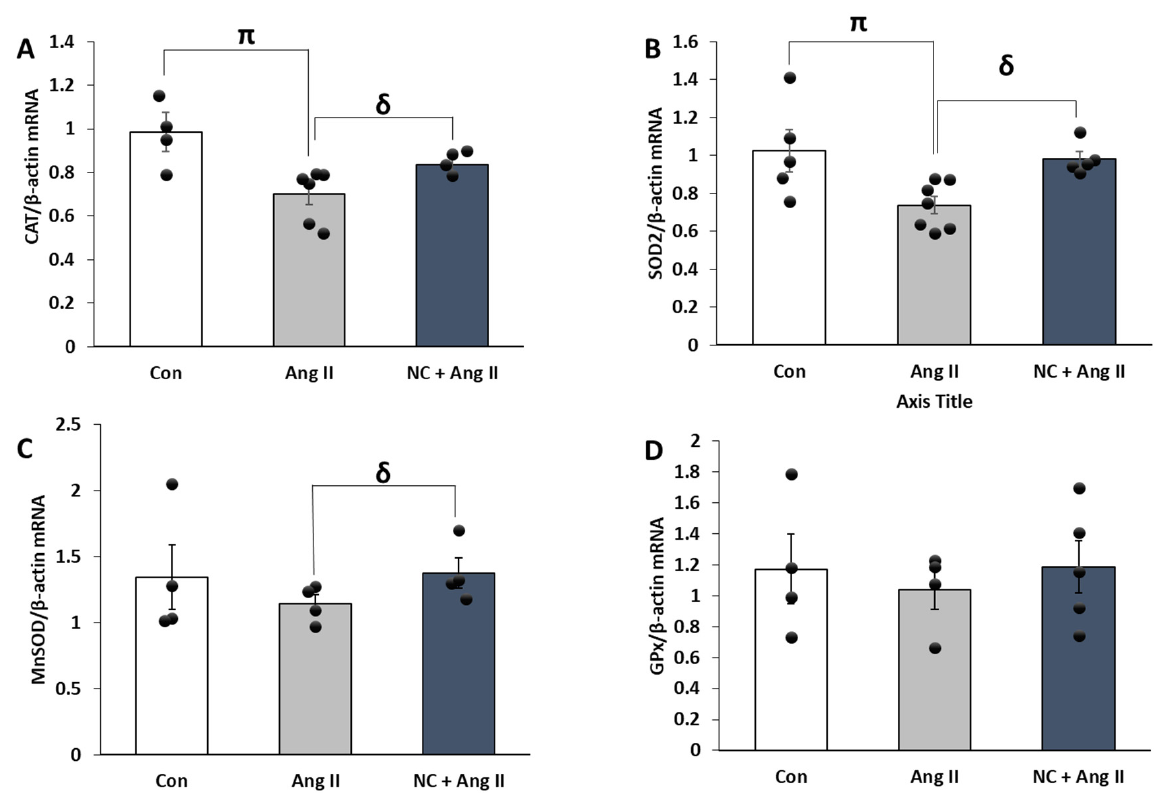
Figure 6. NC increased the expression of genes regulating the antioxidant defense system. mRNA expression levels of hypertrophy genes were examined by RT-qPCR. Ang II decreased mRNA expression of CAT ( A ) and SOD2 ( B ), but not MnSOD ( C ) and GPX ( D ). Treatment with NC (10 µg/mL) prior to Ang II (1 µM) increased SOD2, MnSOD, and CAT mRNA expression compared to Ang II alone. π p < 0.05 vs. Con and δ p < 0.05 vs. Ang II. Values are means ± SEM (n ≥ 4–6 independent